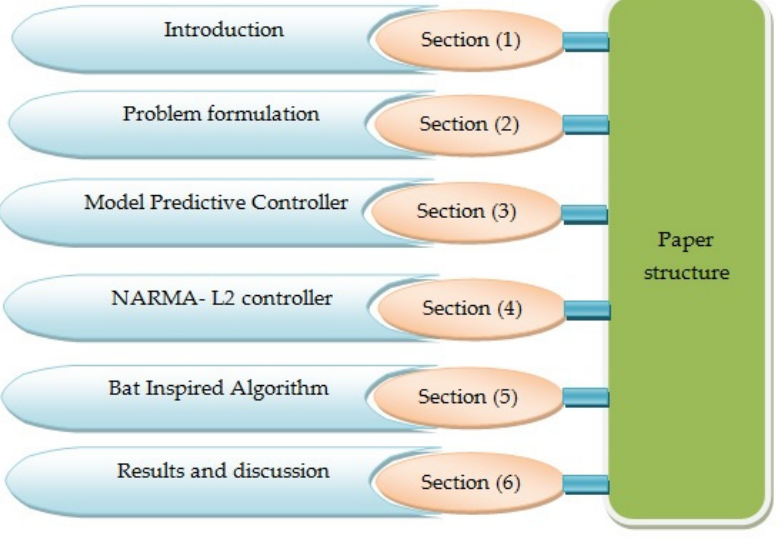
Figure 1. Article Figure 1. article structure.